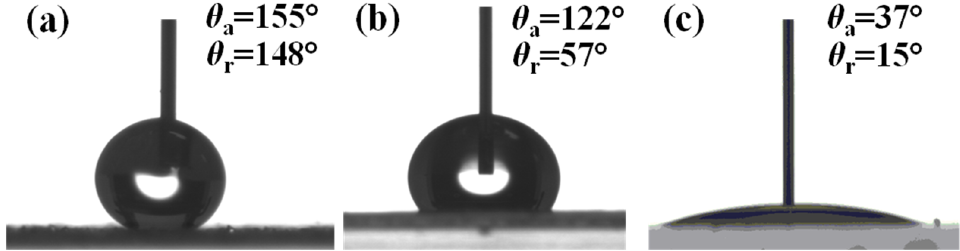
Figure 3. Images showing the advancing water contact angels on: ( a ) polypropylene tape covered with superhydrophobic silica gel; ( b ) polypropylene tape after removing protective linear film; and ( c ) clean glass